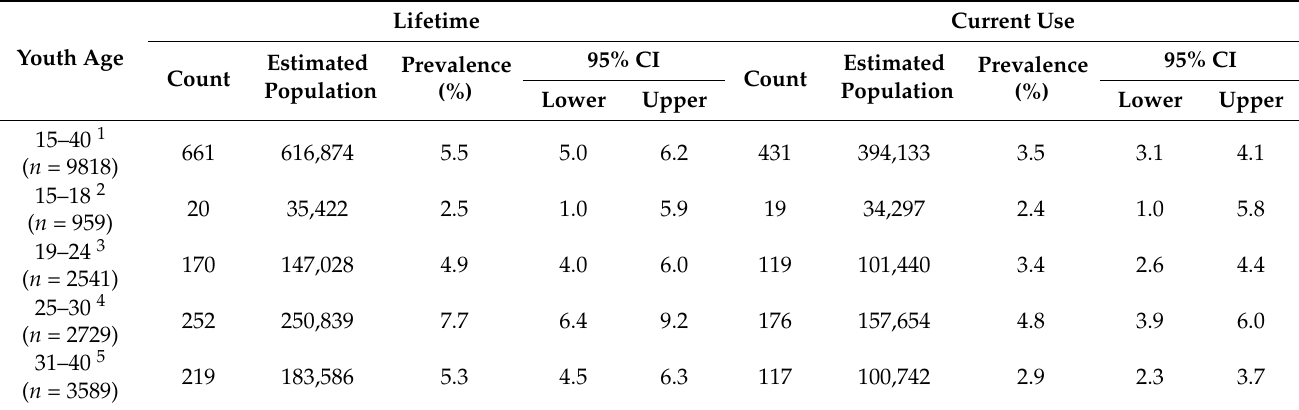
Table 5. Prevalence of lifetime and current drug use by age